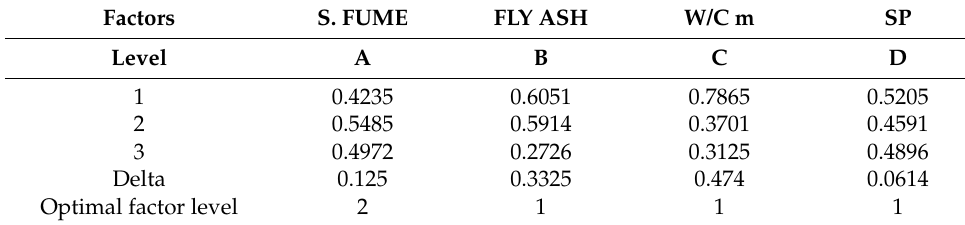
Table 7. Optimum factor levels using